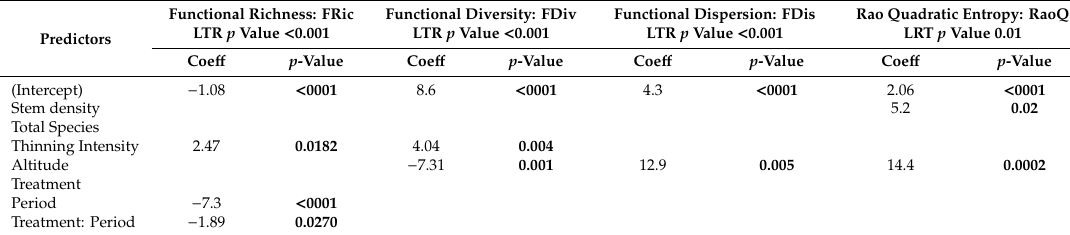
Table 2. Linear mixed models (LMM) of Functional Diversity indices as a function of stem density (stem ha − 1 ), total species, thinning intensity, altitude, treatment, period, treatment:period (fixed e ff ects) and of plot membership nested in sample site (intercept random e ff ects), and likelihood ratio tests (LRT). FEve was not a ff ected by any predictor.